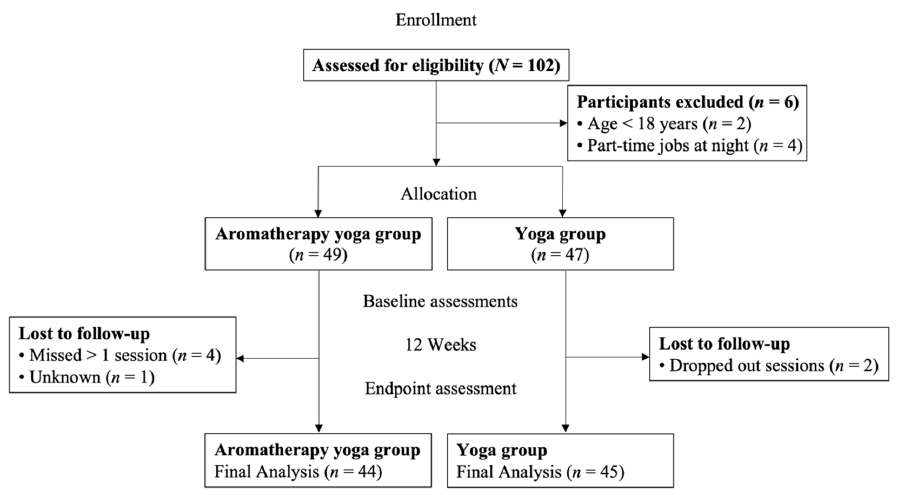
Figure 1. Research flow